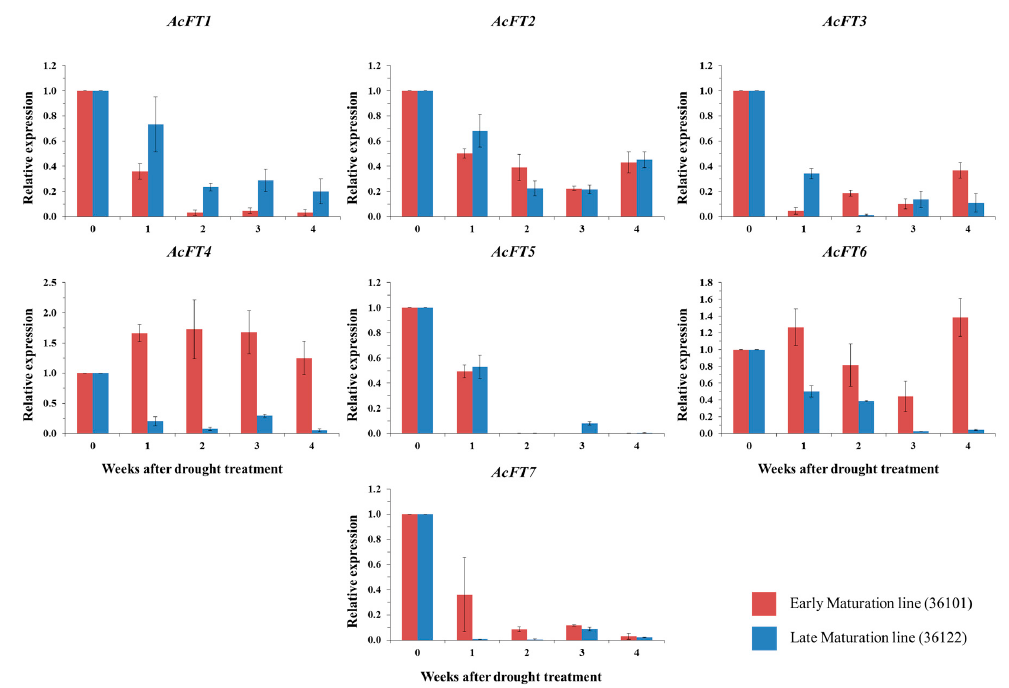
Figure 5. Expression of AcFT genes in EM (early maturation, 36101) and LM line (late maturation, 36122), bulb tissues were studied during Bulb maturation stages under drought condition. In the graph, x axis represent samples at various durations of drought stress (0 to 4 weeks), y axis represent relative expression of FT genes. Data represent an average ± s.e.m of three biological replicates, with transcripts normalized to β -tubulin .